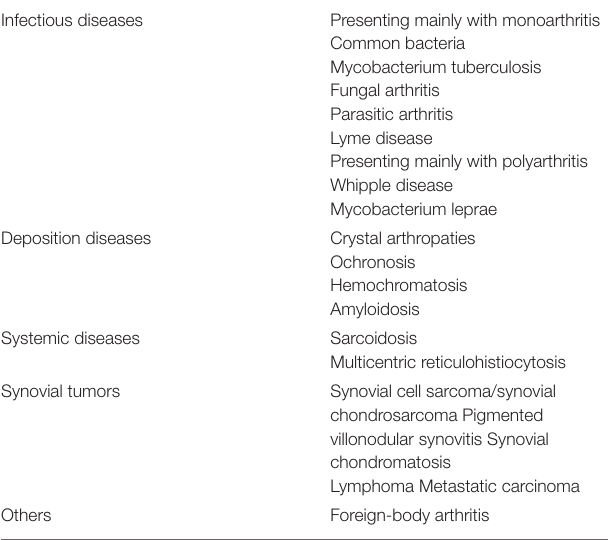
TABLE 1 | Differential diagnosis: WHO deserves synovial biopsy? Infectious diseases